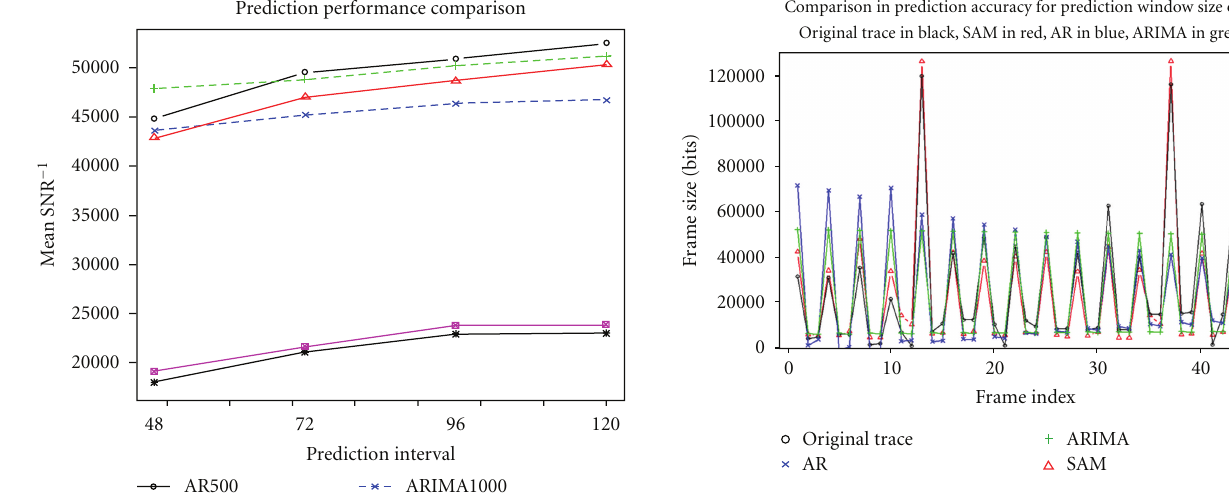
Figure 8: Prediction comparison between AR, ARIMA, and SAM. Table 7: SNR − 1 comparison between AR, ARIMA, and